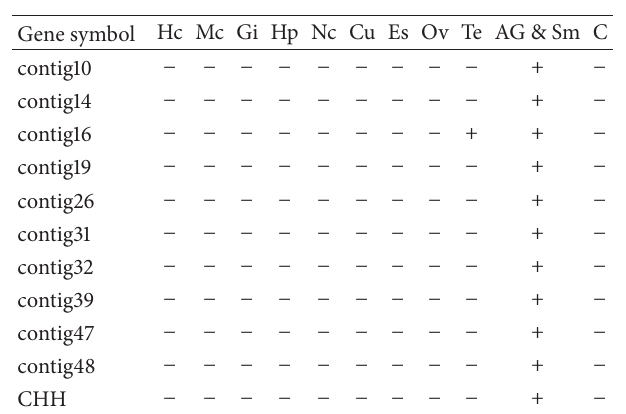
Table 4: Tissue distribution of selected genes from AG-SSH library of F. chinensis .